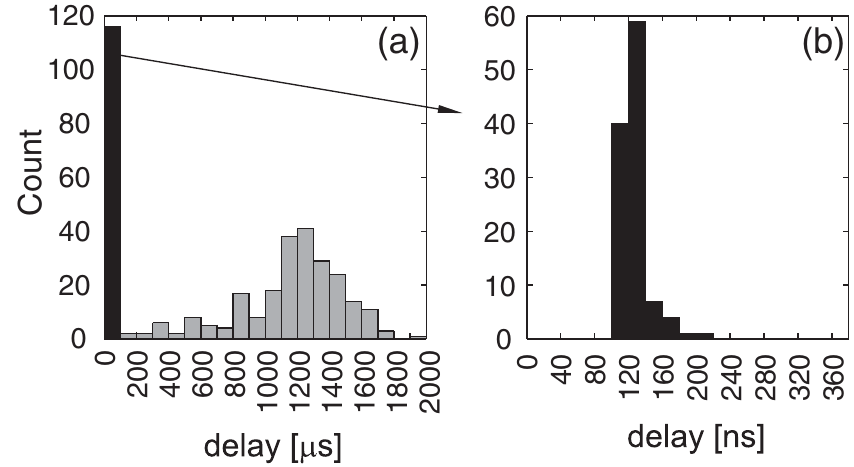
FIG. 9. Histograms of time delays with Mo electrodes during a conditioning experiment (350 breakdowns in total). Delays shorter than 1 (cid:2) s are displayed in black. These short delays are plotted with a higher time resolution in (b).